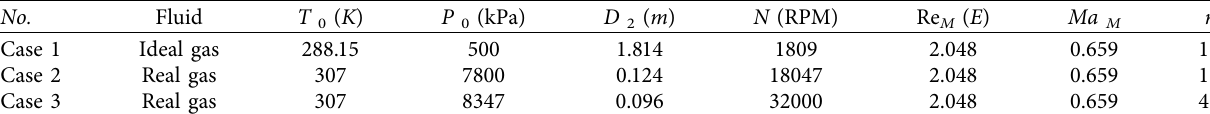
Figure 21: P s / P p along the impeller meridional direction. (a) At the span of 85%. (b) At the span of 15%. Table 6: Settings of the reference cases.